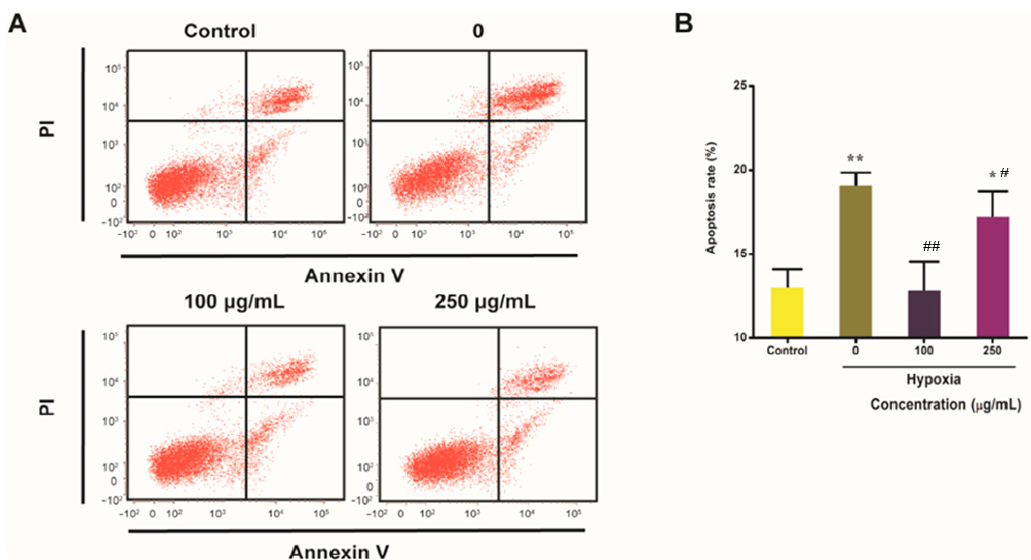
Figure 5. IPA reduce hypoxia-induced apoptosis rate of PC12 cells. ( A ) Cell apoptosis rate was determined by flow cytometry. ( B ) The apoptosis rate for each PC12 cell treatment. Data are expressed as the mean ± SD (n = 3; one-way analysis of variance followed by the T -test). All experiments were conducted in triplicate. * p < 0.05, ** p < 0.01 indicates a significant difference versus the control group. # p < 0.05, ## p < 0.01 indicates a significant difference versus the 0 group under hypoxia condition.